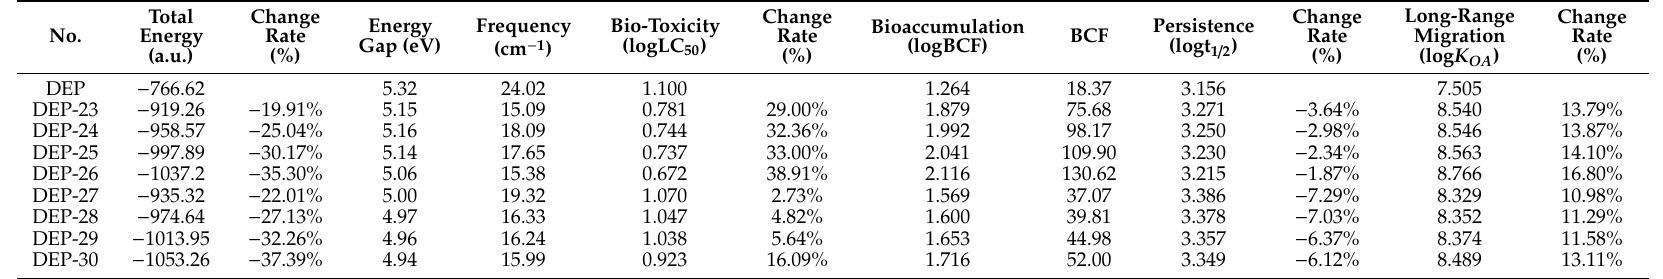
Table 5. Prediction parameters for DEP’s molecular function and environmental friendliness before and after